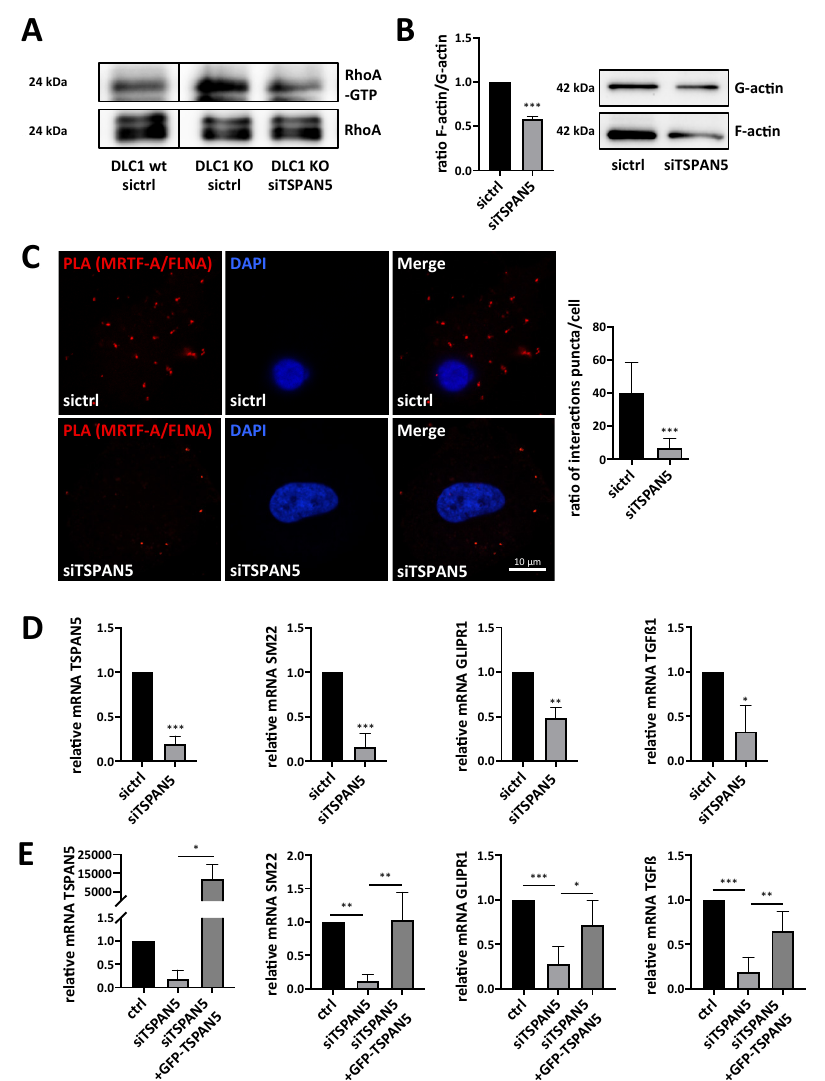
Figure 5. Depletion of TSPAN5 affects the actin/MRTF signaling axis. ( A ) Lysates from HepG2 DLC1 wt (DLC1 wt) and HepG2 DLC1 KO (DLC1 KO) cells transiently transfected with TSPAN5 siRNA (siTSPAN5) or control siRNA (sictrl) were immunoprecipitated with anti-active RhoA antibodies and immunoblotted with anti-RhoA antibodies. Lysates with an equal amount of total protein were directly immunoblotted with anti-RhoA antibodies. The knockdown efficiencies of DLC1 and TSPAN5 are shown in Figure 3B. ( B ) Immunoblotting with anti-actin antibodies and quantification of the ratio of F/G-actin in HuH7 cells transiently transfected with TSPAN5 siRNA (siTSPAN5) as compared to negative control siRNA (sictrl). Data are means ± SD ( n = 3); ***, p < 0.001. ( C ) Immunofluorescence analysis and quantification of proximity ligation assay (PLA) for endogenous MRTF-A and FLNA in HuH7 cells transiently transfected with TSPAN5 siRNA (siTSPAN5) compared to negative control siRNA (sictrl). Scale bar, 10 µm. PLA signals were counted in 15 cells per condition. All data are means ± SD ( n = 3); ***, p < 0.001. ( D ) MRTF target gene expression in HuH7 cells transfected with TSPAN5 siRNA (siTSPAN5) and scrambled siRNA (sictrl), determined by qRT-PCR using SM22-, GLIPR1- and TGFß1-specific primers and 18S rRNA primers for normalization. Values are means ± SD ( n = 3); *, p < 0.05, **, p < 0.01 and ***, p < 0.001. ( E ) MRTF target gene expression in HuH7 cells treated as above and transfected with a GFP-empty vector (ctrl) or GFP-TSPAN5. Values are means ± SD ( n = 3); *, p < 0.05, **, p < 0.01 and ***, p < 0.001. The whole Wester Blots are available at Figure